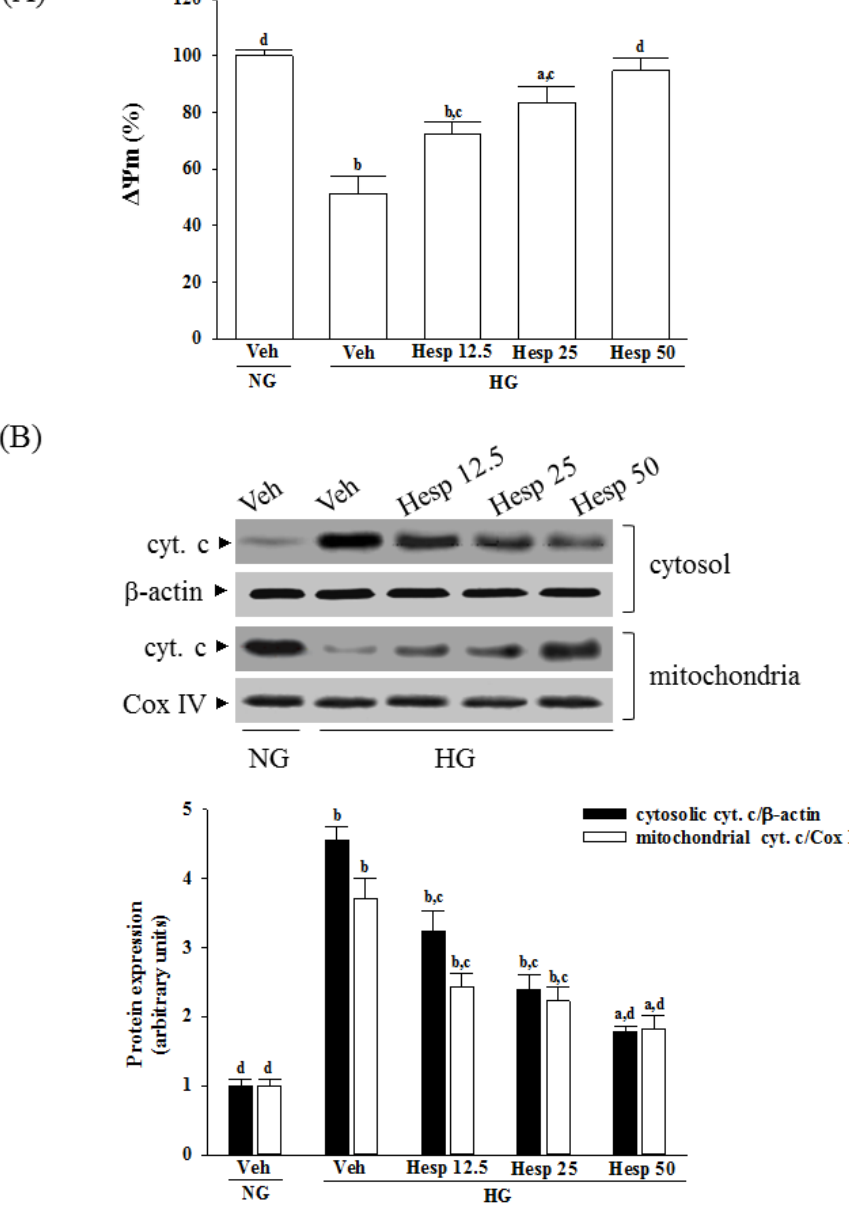
Figure 3. Effects of hesperidin on mitochondrial function in high glucose ‐ treated RGC ‐ 5 cells. The RGC ‐ 5 cells were cultured with normal (NG) or high glucose (HG) plus hesperidin at concentrations of 12.5 (Hesp 12.5), 25 (Hesp 25), or 50 μ mol/L (Hesp 50) for 48 h. ( A ) Effects of treatments on high glucose ‐ induced reduction of mitochondrial membrane potential ( ΔΨ m); ( B ) Effects of treatments on high glucose ‐ induced release of cytochrome c (cyt. c) from mitochondria. The experiments were performed in triplicate and data are presented as the mean ± SD of five independent experiments ( n = 5). a p < 0.05 and b p < 0.01 when compared with the normal ‐ glucose vehicle (Veh) ‐ treated group. c p < 0.05 and d p < 0.01 when compared with the high ‐ glucose vehicle ‐ treated group.